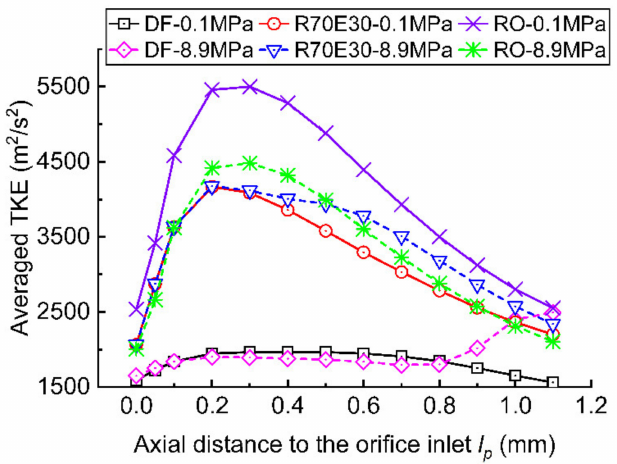
Figure 14. Averaged turbulent kinetic energy (TKE) for DF and R70E30 in cross-section of the nozzle hole along the hole axis under backpressures of 0.1 and 8.9 MPa.